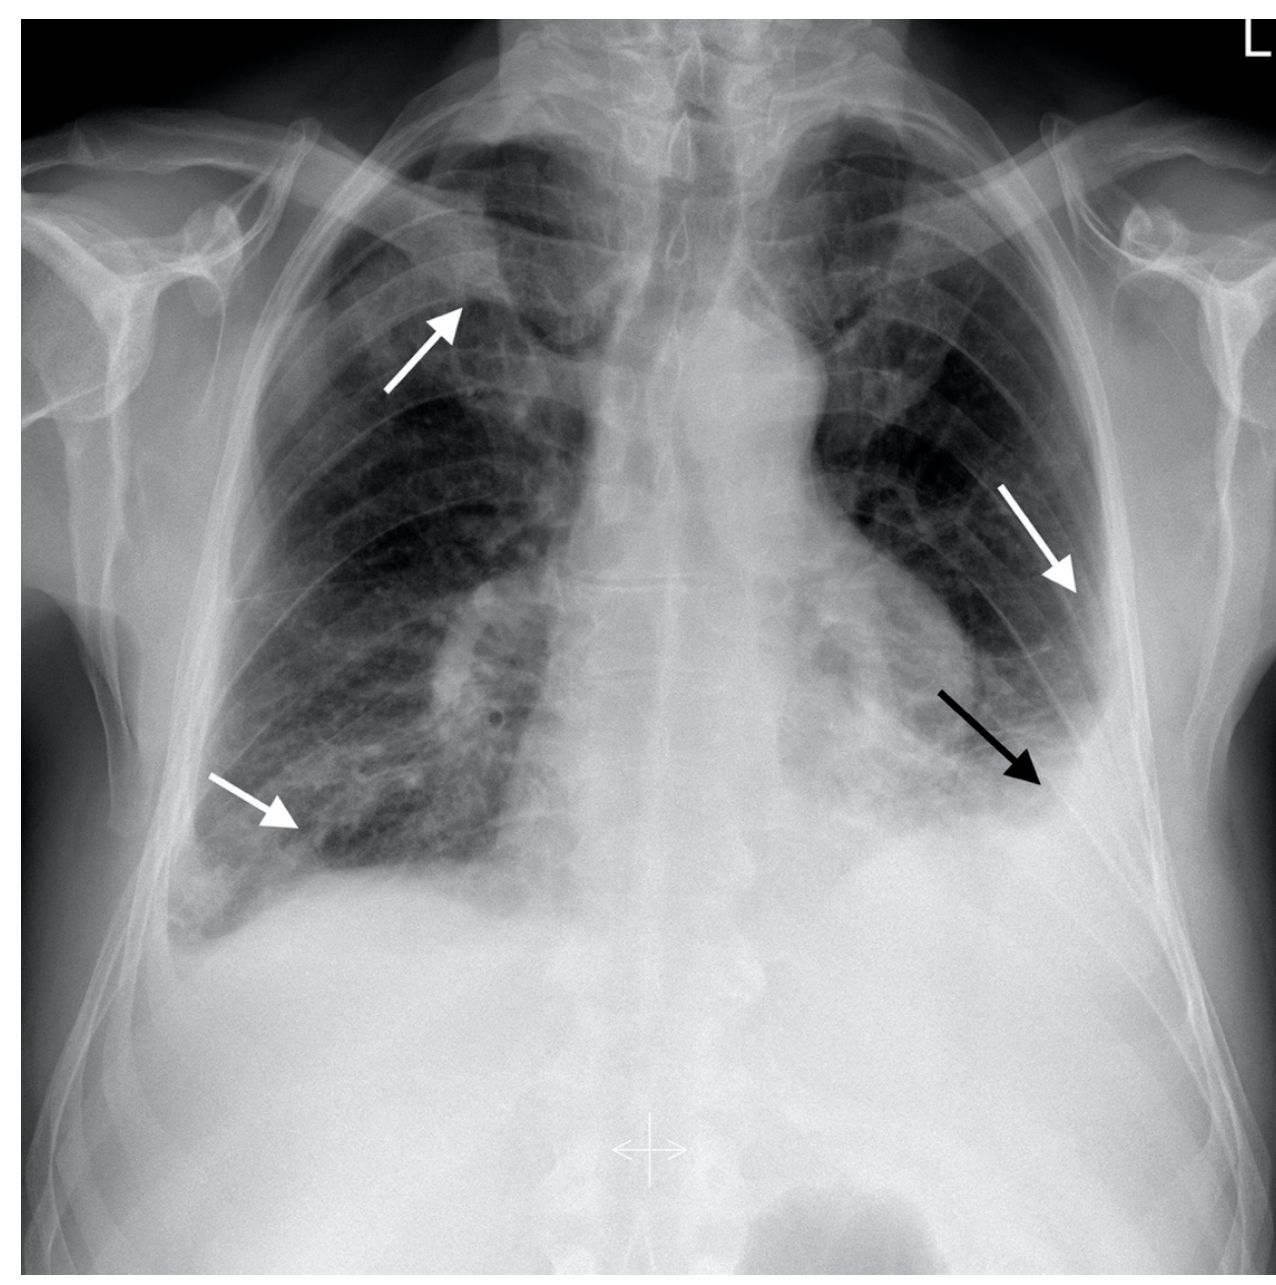
Figure 1. Postero-anterior chest X-ray showing bilateral interstitial infiltrates (white arrows) and left-sided pleural effusion (black arrow).